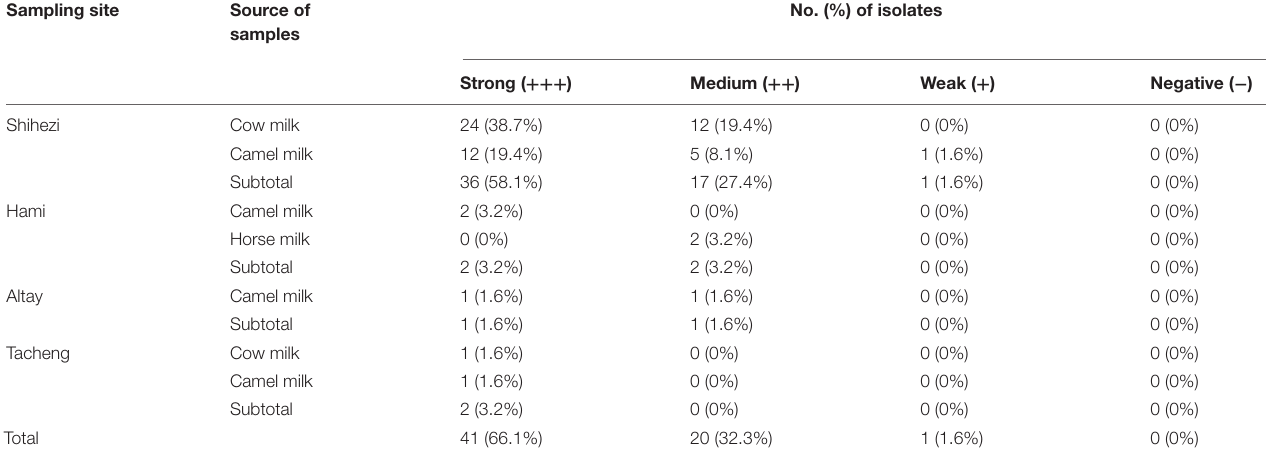
TABLE 7 | Biofilm forming ability of the S. aureus isolates. Sampling